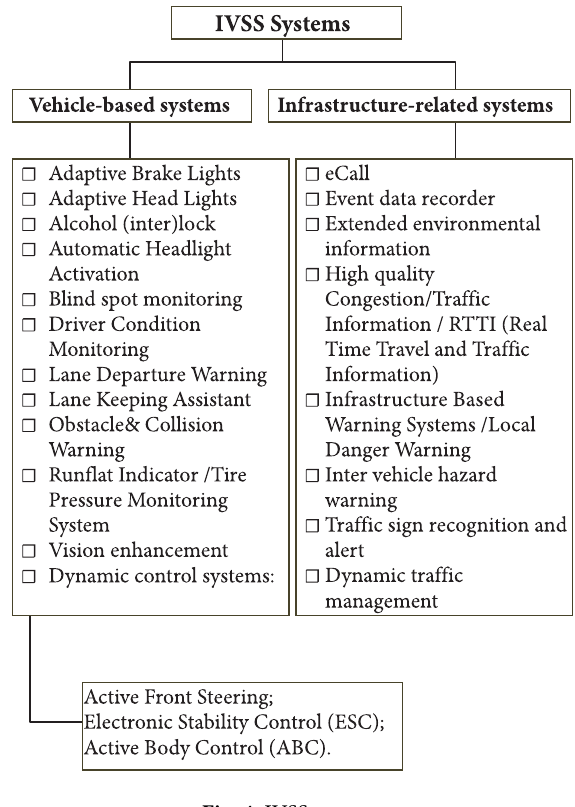
Fig. 4. IVSS systems